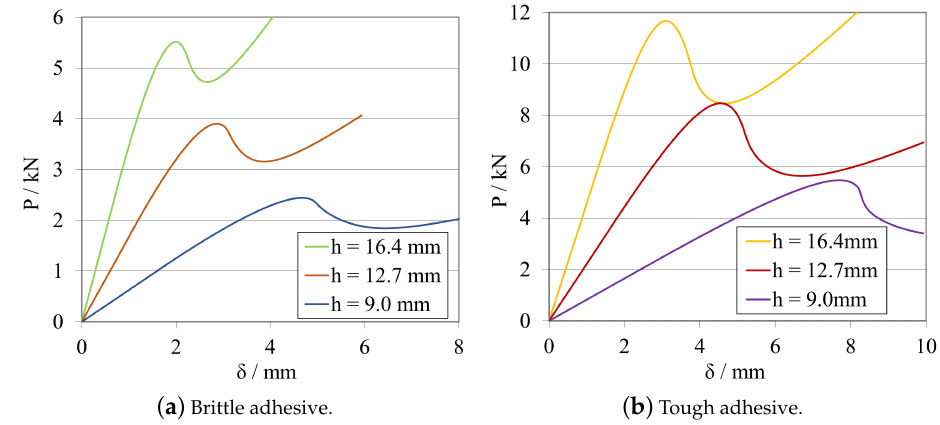
Figure 12. P - δ curves related to the h study.